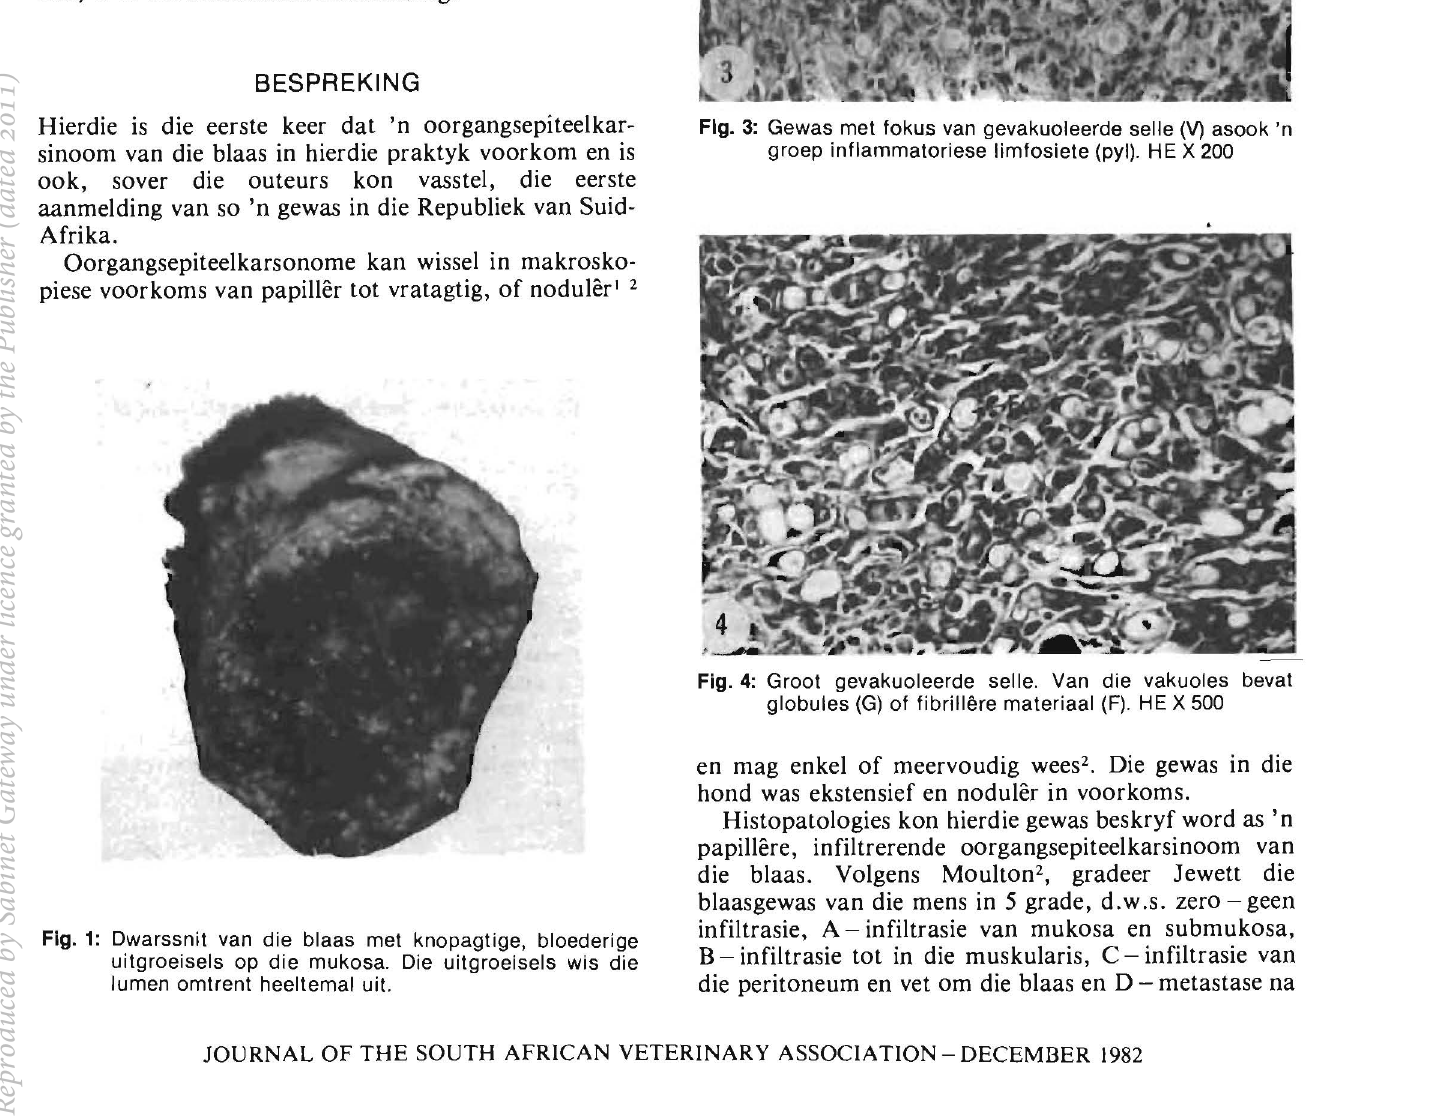
Fig. 2: Plate van gewasselle wat redelik dig teen mekaar Ie. HE x 200